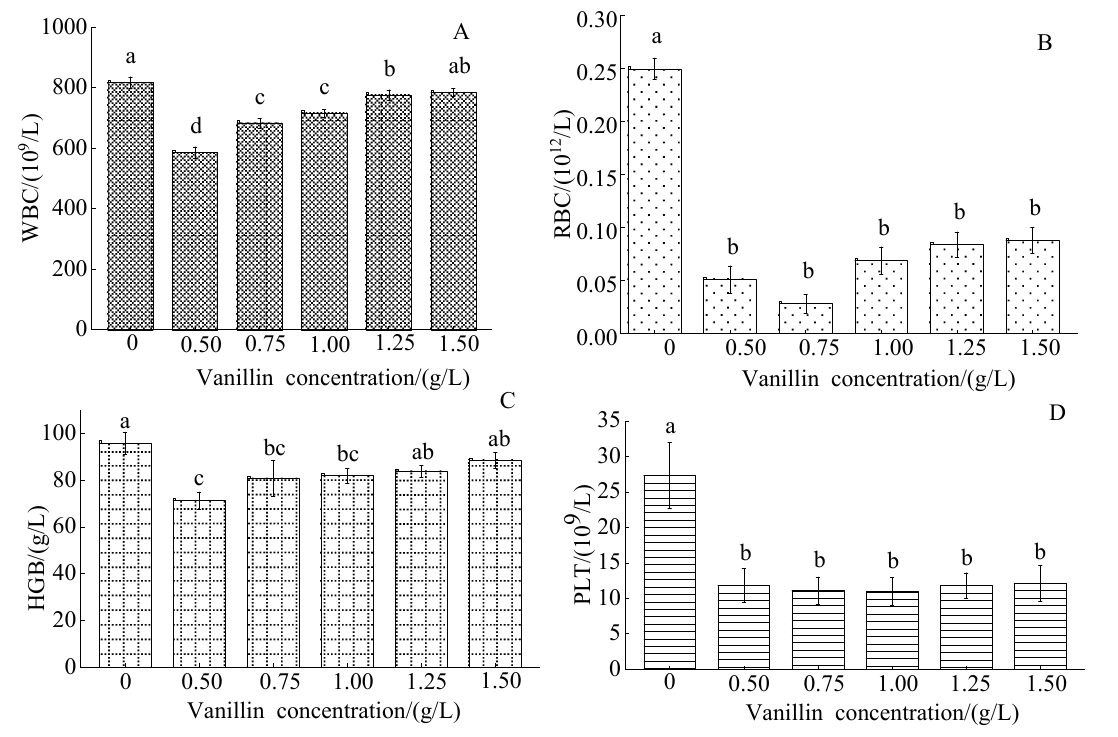
Figure 2. Effect of vanillin concentration on the blood composition of crucian carp: ( A ) white blood cells (WBC); ( B ) red blood cells (RBC); ( C ) haemoglobin (HGB); and ( D ) platelets (PLT). Different letters above the columns indicate a significant difference ( p < 0.05); the same letter indicates no significant difference ( p > 0.05).